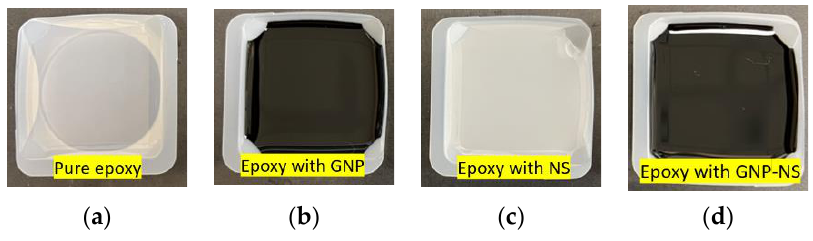
Figure 4. Appearance of epoxy and nanocomposites, ( a ) pure epoxy, ( b ) epoxy with GNP, ( c ) epoxy with NS, and ( d ) epoxy with GNP-NS hybrid fillers.